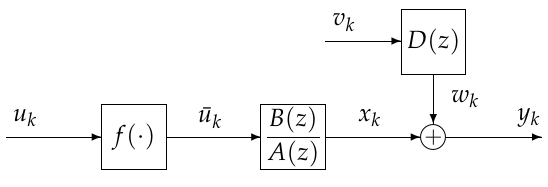
Figure 1. The Hammerstein OEMA